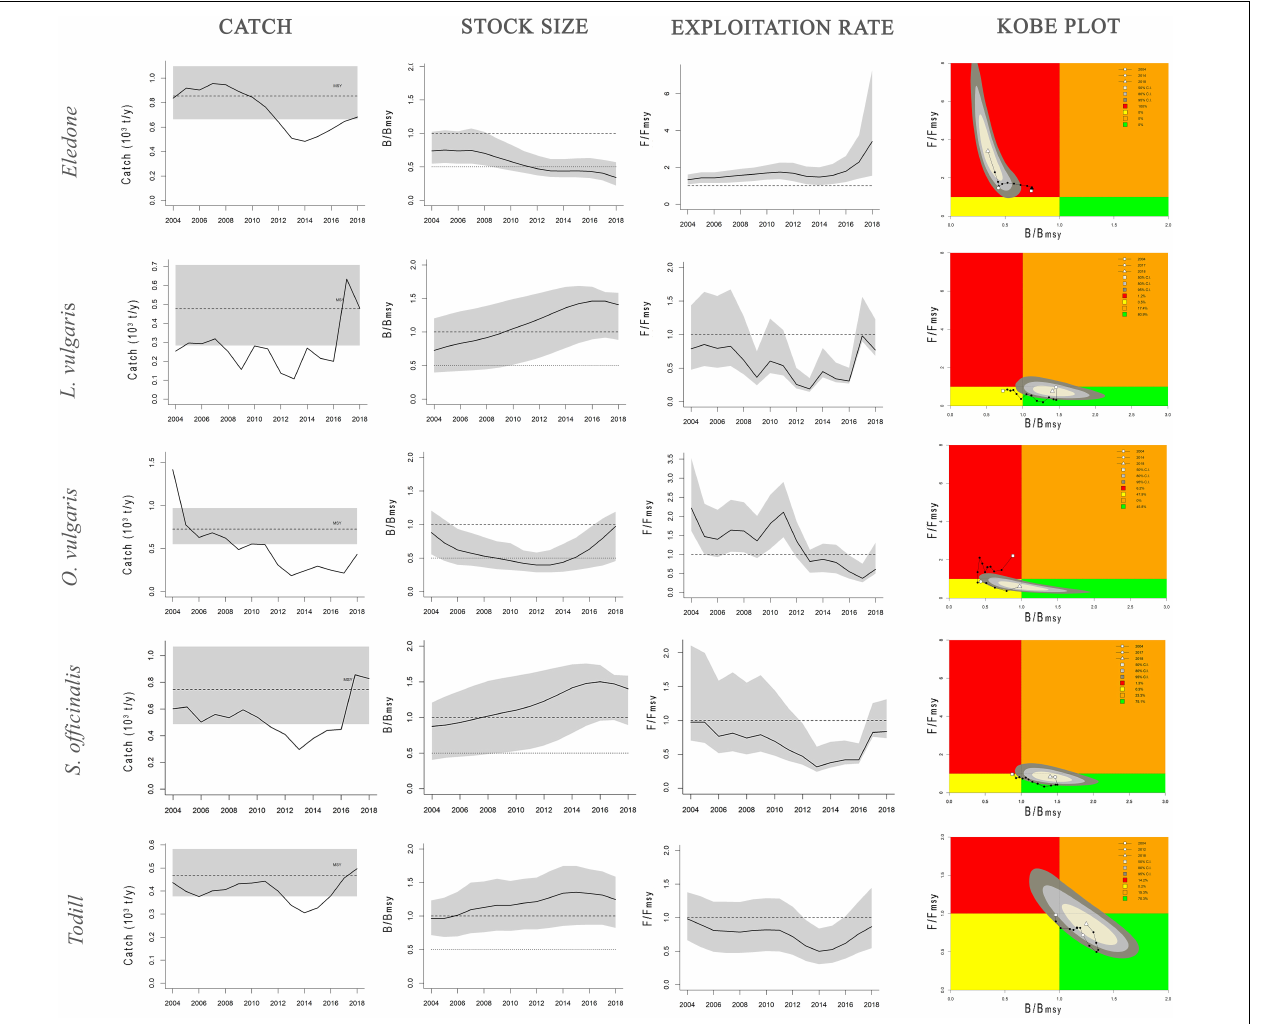
FIGURE 3 | Dynamics of cephalopod stocks in the GSA16 estimated by CMSY and BSM models. Catch panel: black solid line shows the estimated catches, black dashed line the mean value of MSY, gray shaded area the 95% confidence interval of MSY. Stock size and exploitation rate panels: trend of B/B MSY and F/F MSY with gray shaded area showing the 95% confidence interval. Kobe plot panel: B/B MSY against F/F MSY for the years 2004–2018. Quadrants are color-coded, i.e., red area: stocks that are both overfished (low relative biomass) and in overfishing (high exploitation rate) (B ≤ B MSY ; F ≥ F MSY ); orange area: relative biomass is quite high but exploitation rate is high (B ≥ B MSY ; F ≥ F MSY ); yellow area: recovering stocks (B ≤ B MSY , F ≤ F MSY ); green area: stocks subject to sustainable exploitation rate and with healthy stock biomass that can produce high yields close to MSY (B ≥ B MSY , F ≤ F MSY ). Shaded areas indicate the confidence interval at 50% (light gray), 80% (gray), and 95% (dark gray) of the reference points during the last